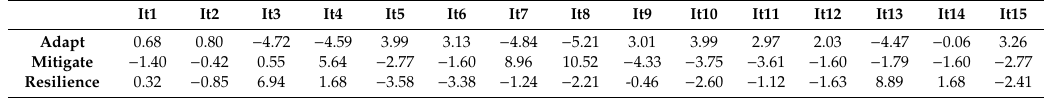
Table 10. Residuals of data for Niger.